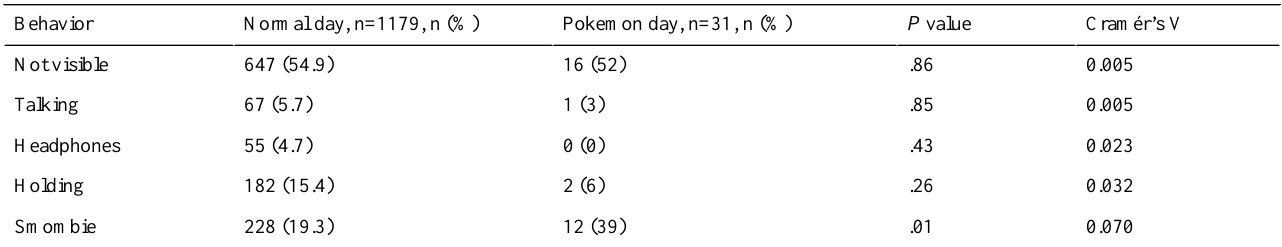
Table 12. Influence of the Pokemon Go Community Day on the smartphone usage behavior in young people (globally P =.06, V=0.087)